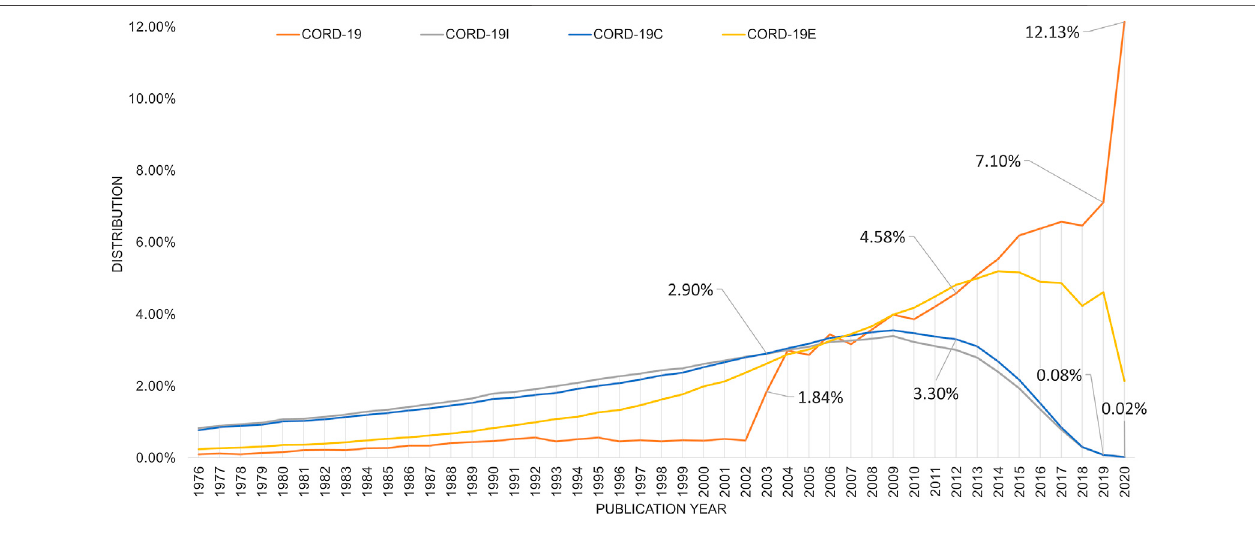
FIGURE 5 | Distribution of articles in percent per year for COVID-19 Research Dataset (CORD-19) (seed), CORD-19I (in fl ection), CORD-19C (closure), and the enclosure graph CORD-19E generated by the bidirectional citation expansion. Callouts are percentages for CORD-19 and CORD-19C for the years 2002, 2012, and 2019 – 2020, corresponding to the SARS, MERS, and COVID-19 outbreaks, respectively.